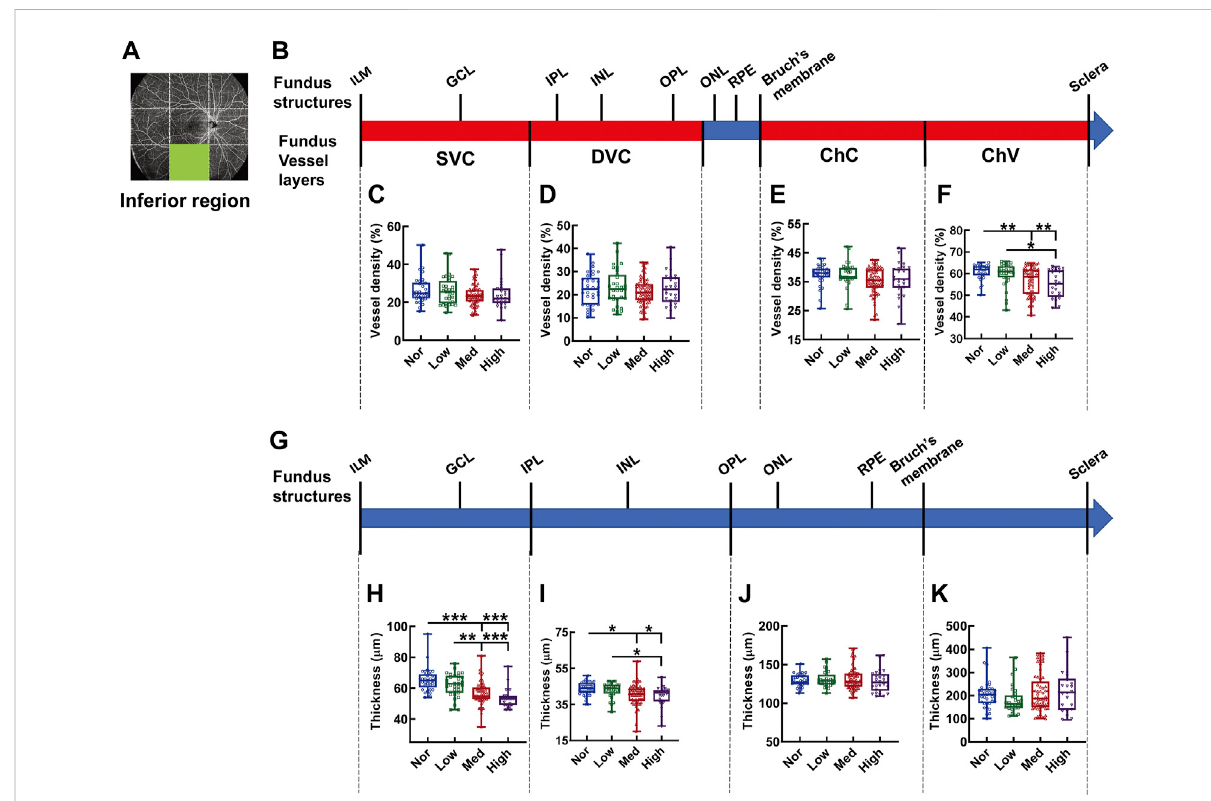
FIGURE 10 Vessel layer densities and structure thicknesses at the inferior region of the fundus. Position of the inferior region of the fundus is illustrated in (A) .Schematicillustrationofvessellayersinthefundusisshownin (B) .Vesseldensitiesofsuper fi cialvascularcomplex (C) ,deepvascularcomplex (D) , choriocapillary (E) , and choroidal vessel (F) layers are quanti fi ed and compared. Schematic illustration of segments in the fundus is shown in (G) . Thicknesses of the segments from IML to IPL (H) , from IPL to OPL (I) , from OPL to Bruch ’ s membrane (J) , and from Bruch ’ s membrane to the sclera (K) are quanti fi ed and compared. * p < 0.05, ** p < 0.01, *** p < 0.001. SVC, super fi cial vascular complex; DVC, deep vascular complex; ChC, choriocapillary layer; ChV, choroidal vessel layer; NOR, normal group; Low, low-myopia group; Med, medium-myopia group; High, high